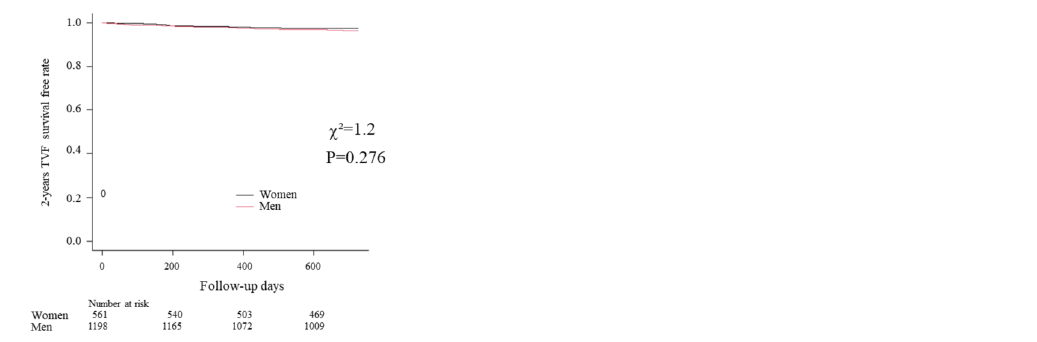
Figure 1. Kaplan–Meier time to event curves for target vessel failure during 2-year follow-up across the sexes. The 2-year TVF survival free rate was compared across the sex. TVF Target vessel